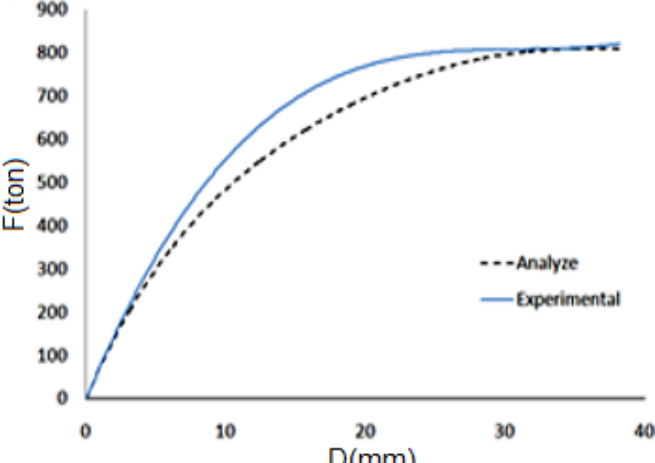
Fig. 3. Comparison of the force-displacement diagram of sample of Sabouri-Ghomi with Analyzed model in